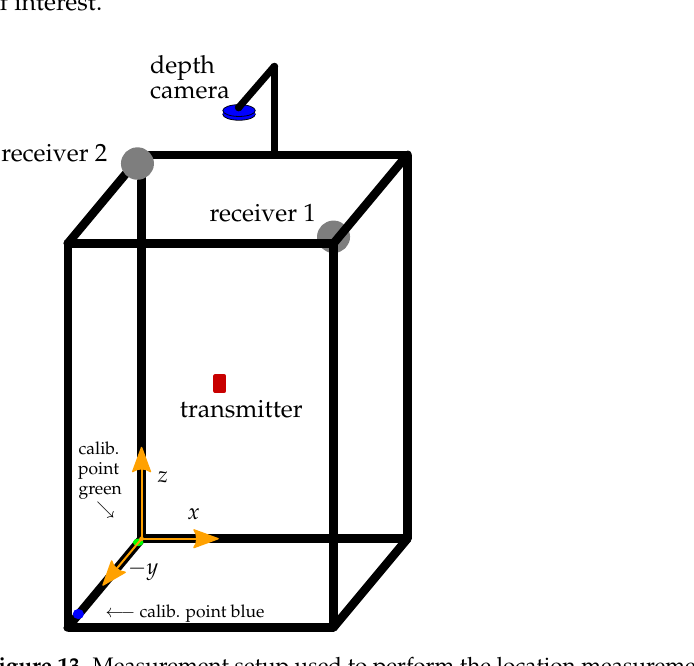
Figure 13. Measurement setup used to perform the location